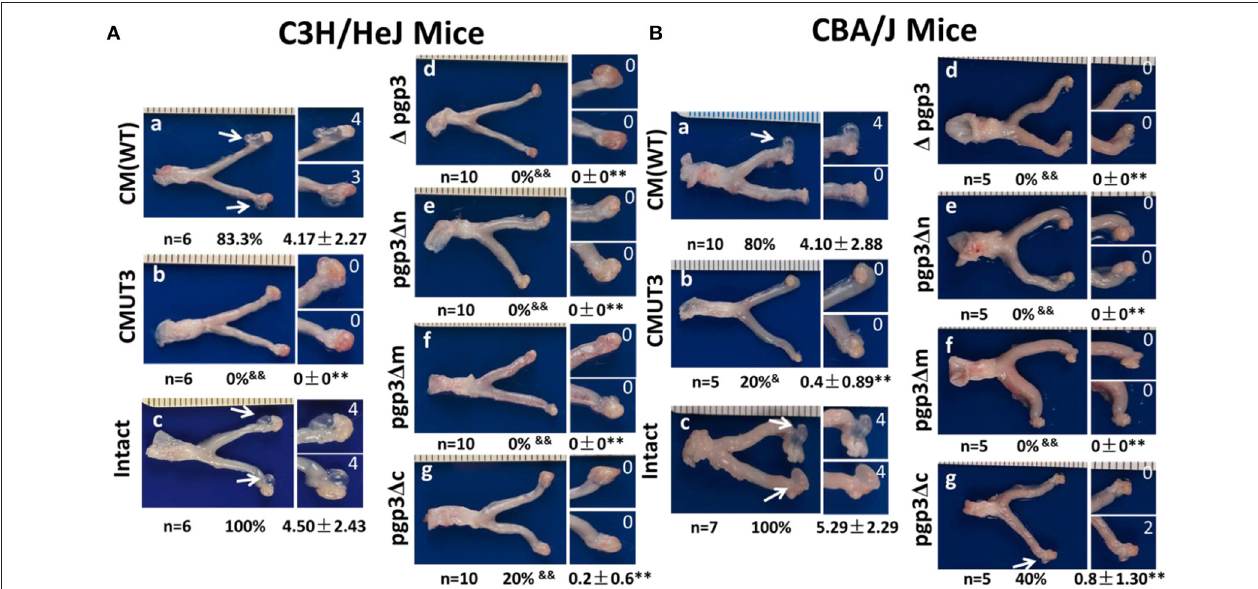
FIGURE 3 | Effect of Pgp3 domain deletion on chlamydial pathogenesis. Wild-type C. muridarum (WT, a), plasmid-free (CMUT3, b) or CMUT3 transformants (pGFP::CM [intact], c; 1 pgp3, d; pgp3 1 n, e; pgp3 1 m, f; pgp3 1 c, g) were used to intravaginally infect C3H/HeJ (A) and CBA/J mice (B) . Sixty days after inoculation, the genital tracts were harvested, and the gross pathology in the UGT was evaluated. Left, representative image of the genital tract; right, representative image of the oviduct/ovary. The total number of mice (n) and the incidence (%) and severity ( ± SD) of hydrosalpinx are shown. pgp3 1 n, pgp3 1 m, and pgp3 1 c did not induce severe hydrosalpinx. & P < 0.05, && P < 0.01; Fisher’s exact test. ** P < 0.01; Mann–Whitney U rank-sum